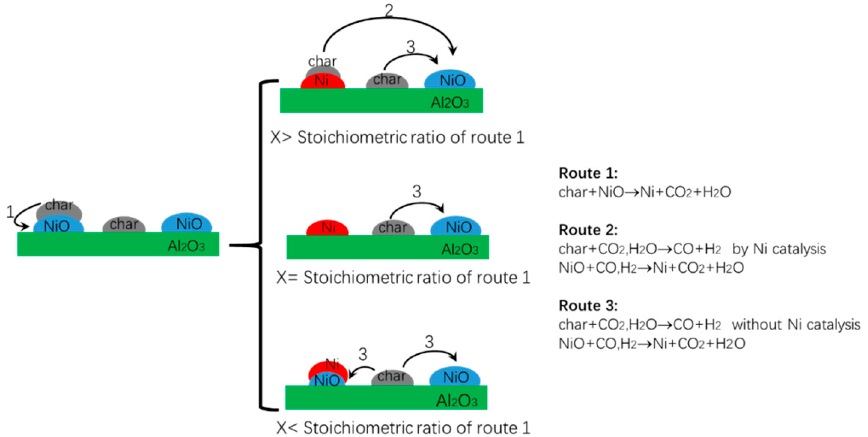
Figure 7. Schematic diagram of possible routes for the reduction of the NiO/Al 2 O 3 by the in situ generated biochar from citric acid pyrolysis (X is the ratio of the biochar and the NiO in contact with each other).